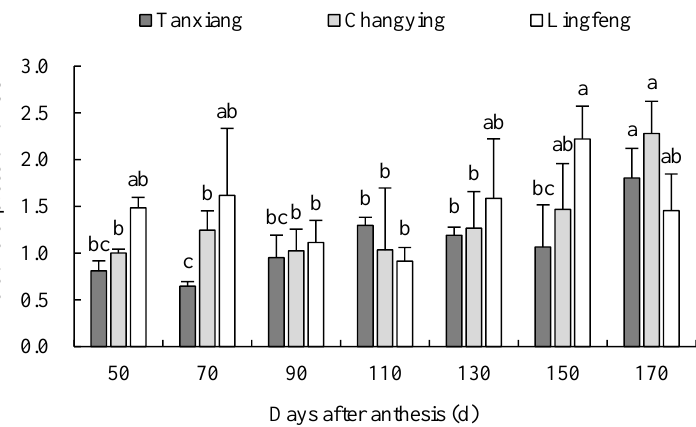
Figure 6. Expression of CS in Chinese olive fruit at different developmental stages. Bars represent the standard deviation for three biological replicates. Different letters indicate significant differences among different stages of the same cultivars ( p < 0.05).